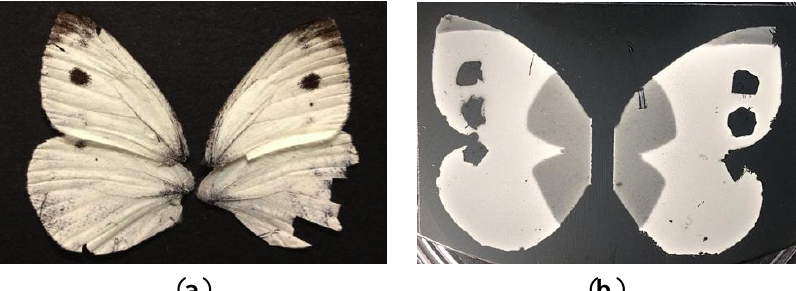
Figure 6. ( a ) Actual Pieris rapae butterfly wings showing white coloration with black spots; ( b ) result of Pieris rapae replication: the white surface is produced by SU-8 beads with diameters in the range of 100 to 500 nm. Black dots are the result of the black pyrolyzed layer without